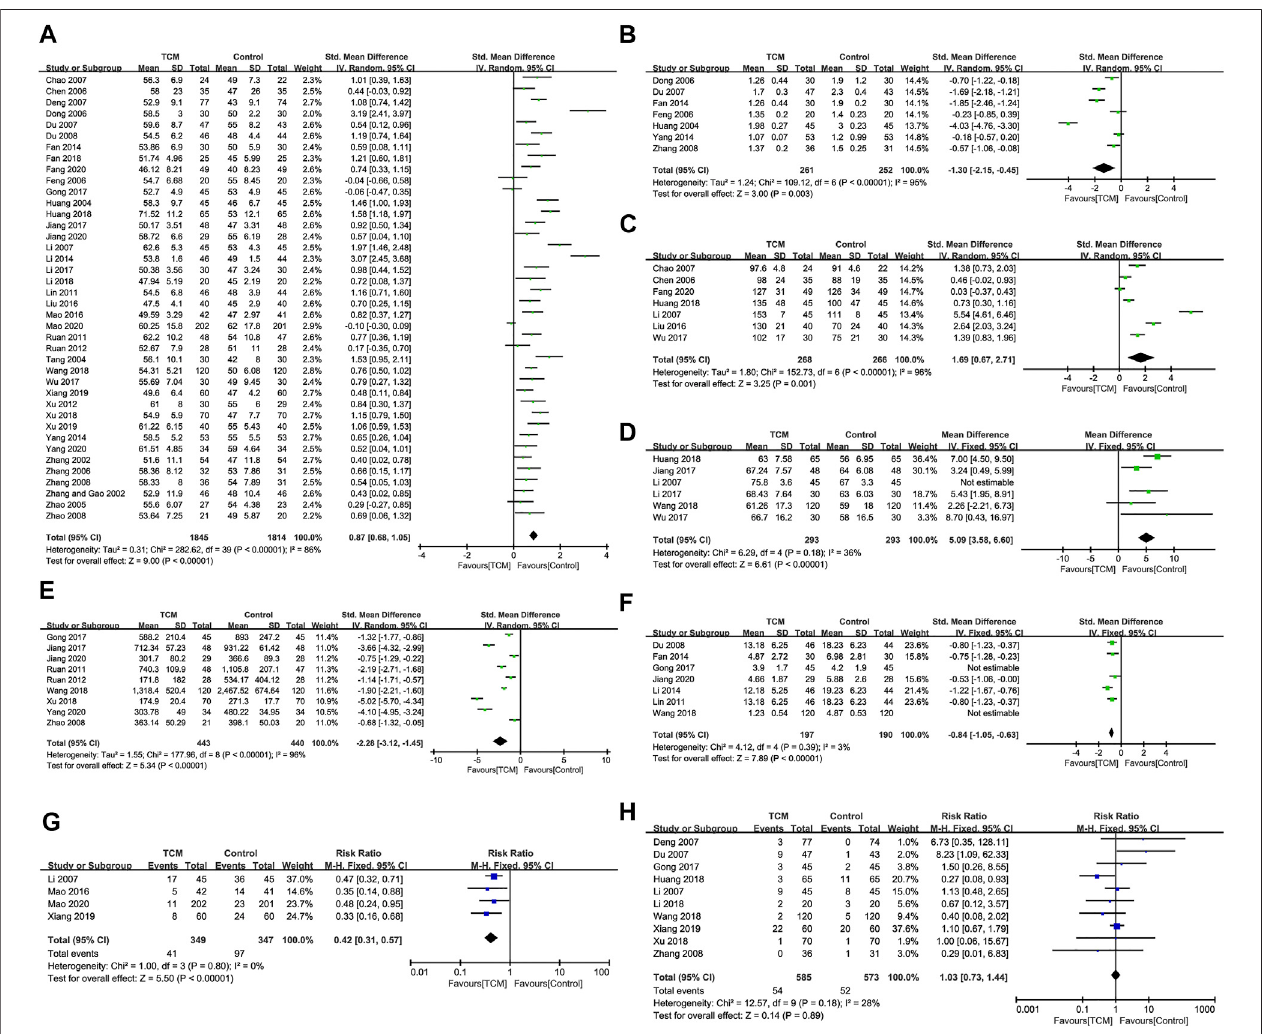
FIGURE 5 | Indicators for improving cardiac function, serum indicators, and MACE. (A) . LVEF. (B) . WMS. (C) . E/A. (D) . SV. (E) . BNP/NT-pro BNP. (F) . CRP/hs- CRP. (G) . MACE. (H) . Other adverse events.